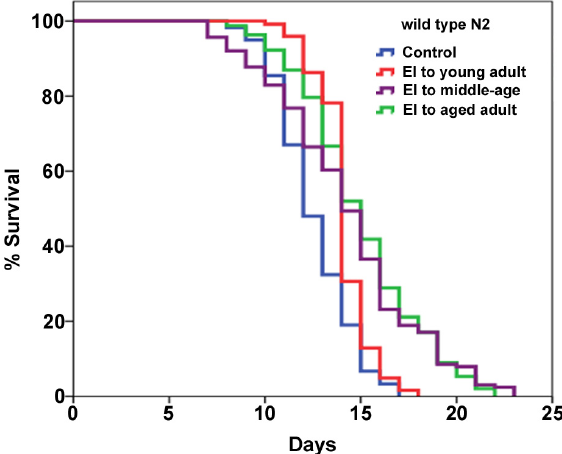
Figure 2. Longer time supplementation with CBE results in more prolonged lifespan extension in C. elegans . Wild type N2 worms were supplemented with 2 mg/mL of CBE through the early-start intervention. Each lifespan experiment was repeated at least three independent times with similar results. Quantitative data and statistical analyses for the representative experiments are included in Table 2. EI represents the early-start